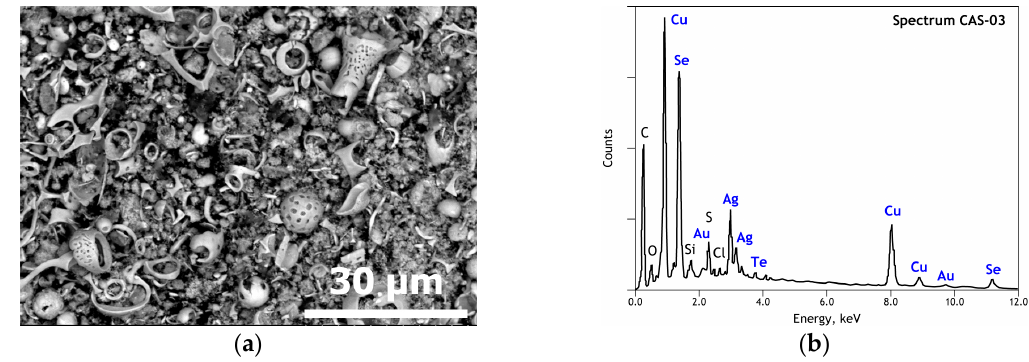
Figure 1. SEM-EDS results of initial copper anode slime: ( a ) General view (backscattered electron micrograph) of the used sample; ( b ) Overall EDS analysis of the used sample.